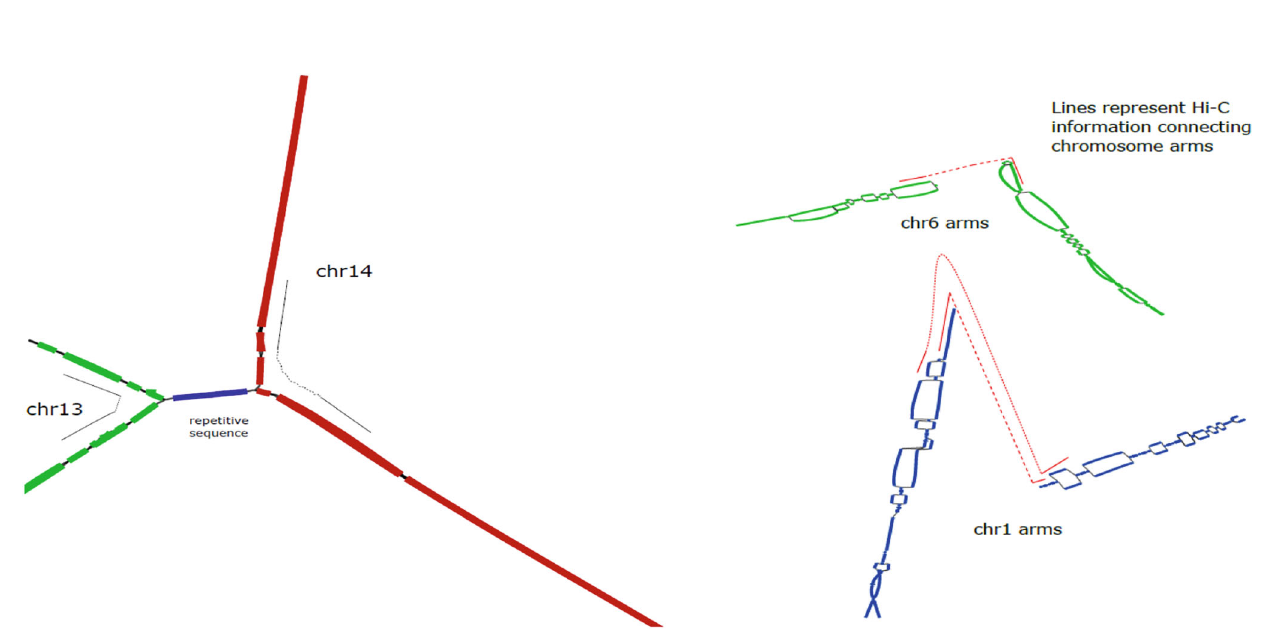
Fig. 3 | Left: Regions from two chromosomes (chr13 and chr14) are fused in a component due to a common repetitive sequence in HG002. The Hi-C infor- mation in the graph (speci fi cally along each green and red path) is helpful for disentangling the chromosomes. Right: The starting regions of chromosome